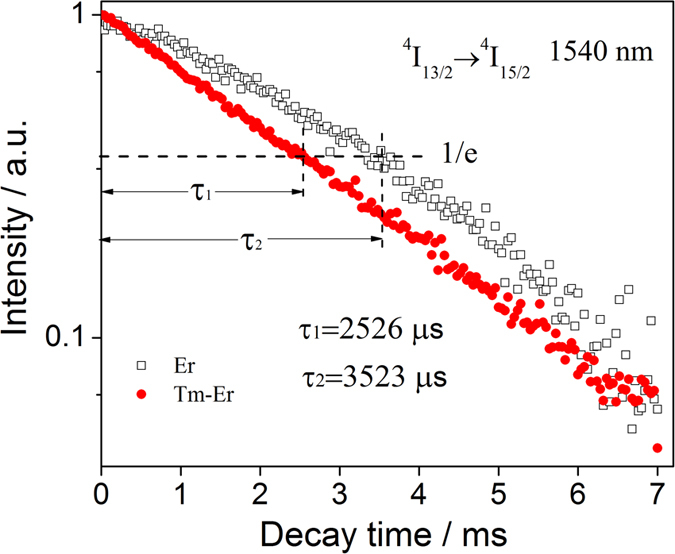
Decay curves of 4I13/2 → 4I15/2 emission (1540 nm) in Er3+ doped and Tm3+-Er3+ co-doped 65GeS2–25In2S3–10CsI glasses.